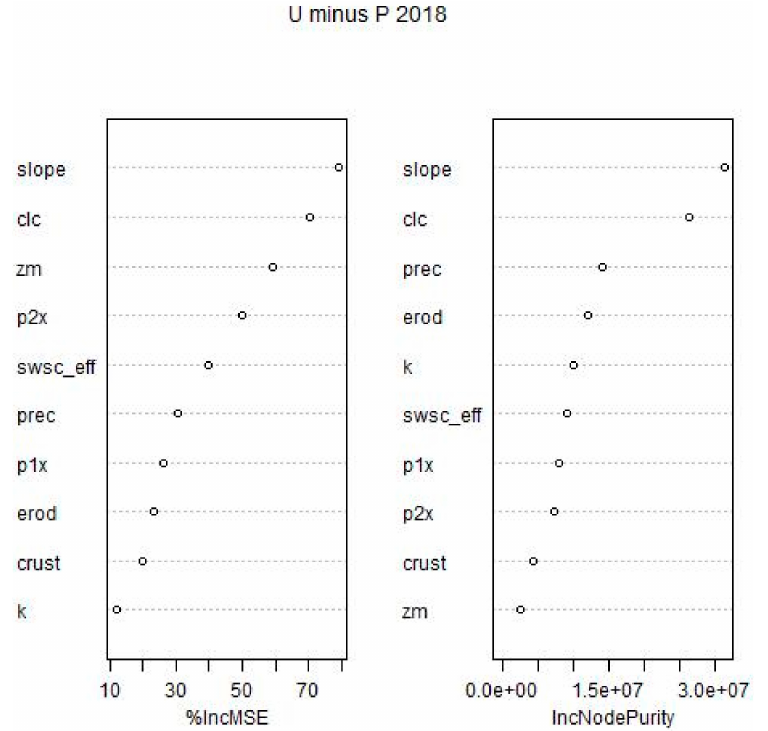
Figure 12. Variable importance based on Random Forest regression for the di ff erences between the USLE (U) and PESERA (P) models for 2018 predictions. (P—PESERA; U—USLE; %IncMSE—percentage